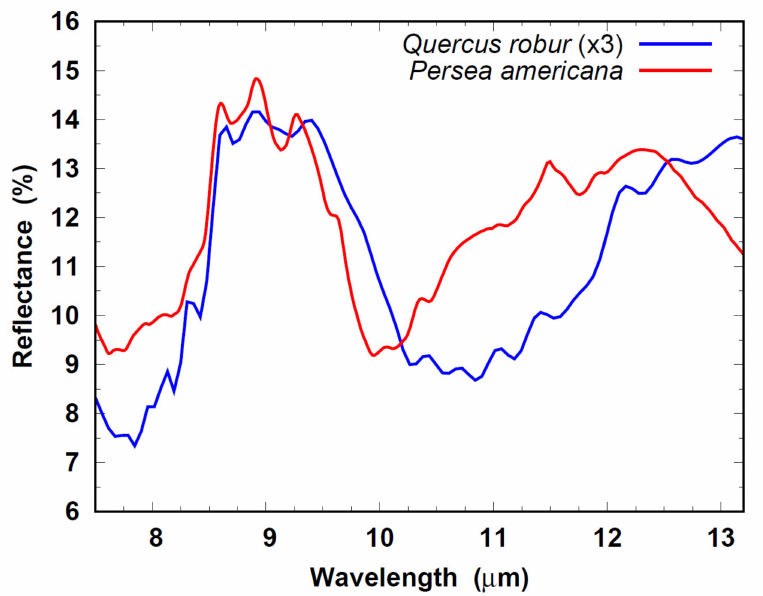
Figure 13. Persea americana and Quercus robur spectra most frequently ID’d at the Huntington Gardens avocado orchard. The Q. robur library spectrum has been scaled by a factor of 3. Ironically, the Q. robur library spectrum is more proficient at inferring the presence of P. americana than Q. robur , or any other Quercus species (see also Section